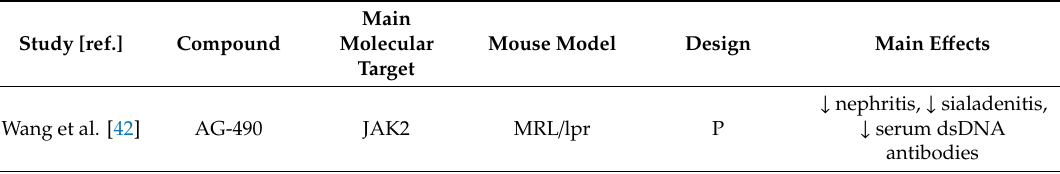
Table 3. In vivo studies on murine models of lupus, assessing the potential therapeutic role of JAK / STAT